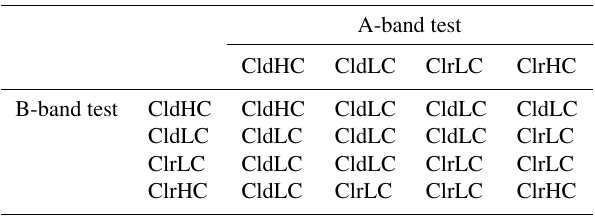
Table 3. The logic table for combining the cloud mask results from the A- and B-band tests. Acronyms: CldHC, cloud with high confi- dence; CldLC, cloud with low confidence; ClrHC, clear with high confidence; ClrLC, clear with low